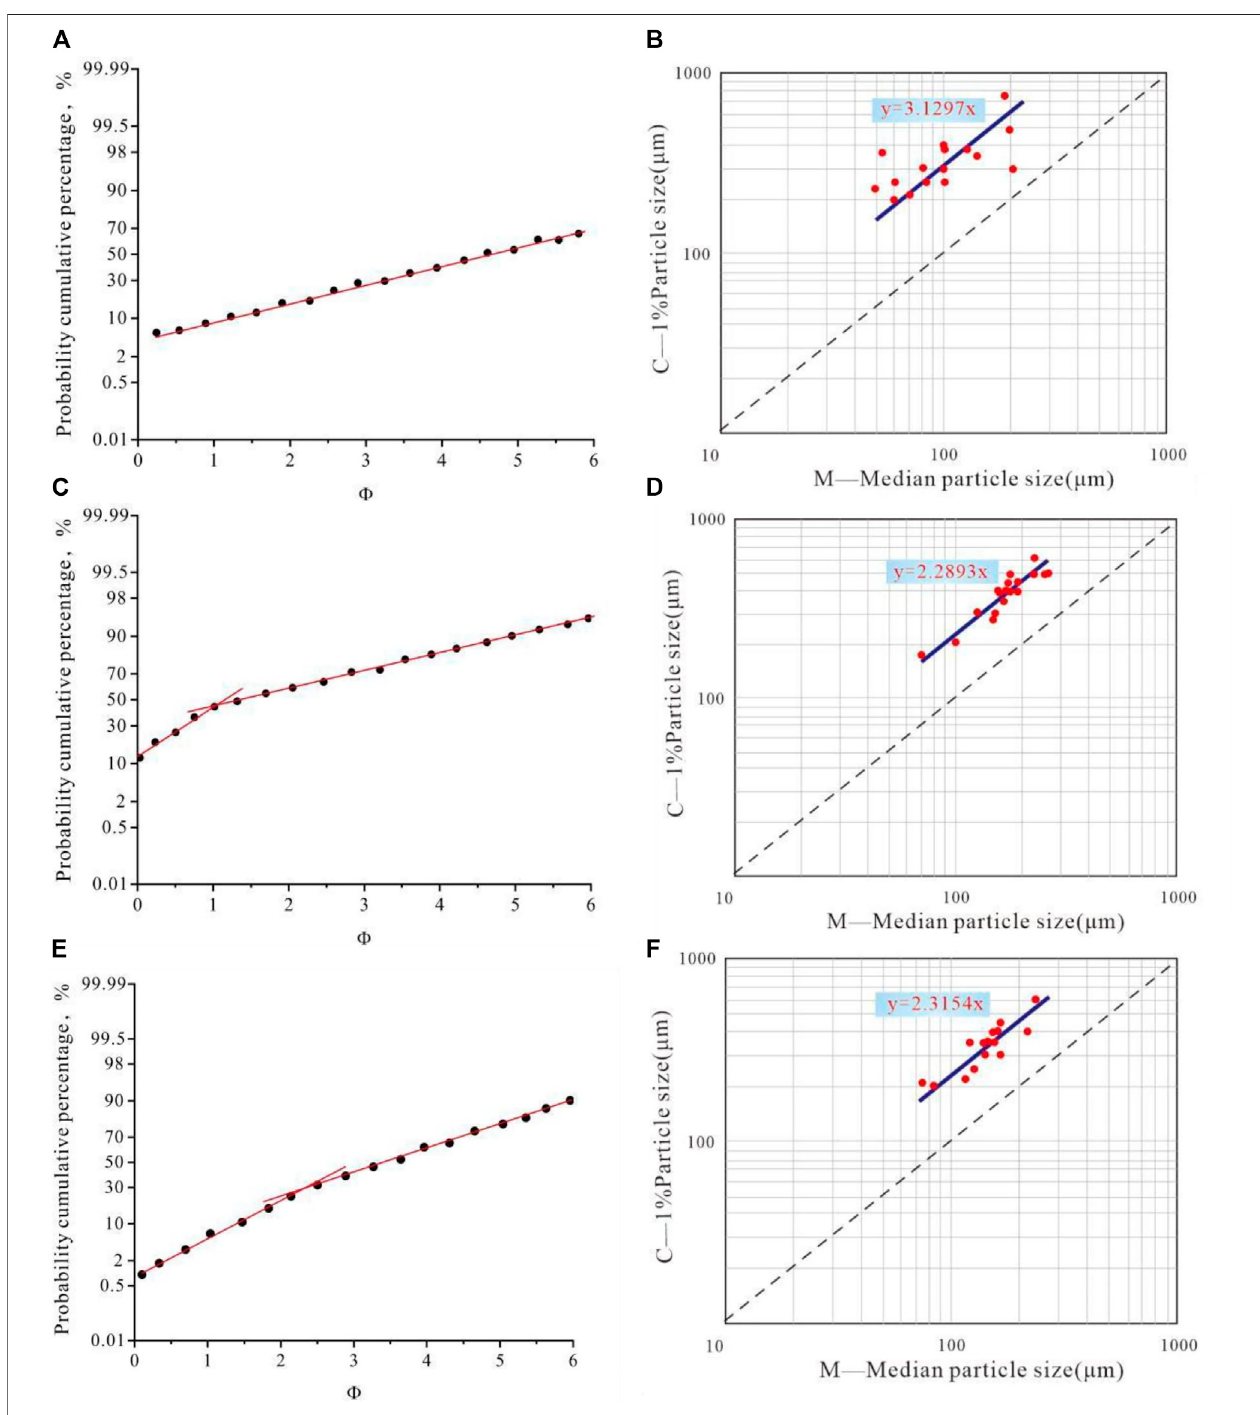
FIGURE 3 | Particle size analysis results of different gravity- fl ow types. (A) Cumulative curve of particle size probability of sandstone samples in slide-slump rocks taken from well Zhuang42, 1859.3 m; (B) C-M particle size distribution map of sandstone samples in slide-slump rocks; (C) Cumulative curve of particle size probability ofsandstonesamplesinsandyturbiditytakenfromwellZhuang35,1,695.7 m; (D) C-Mparticlesizedistributionmapofsandstonesamplesinsandyturbiditycurrent; (E) CumulativecurveofparticlesizeprobabilityofsandstonesamplesinturbiditytakenfromwellBan29,1,654.4 m; (F) C-Mparticlesizedistributionmapofsandstone samples in turbidity current.